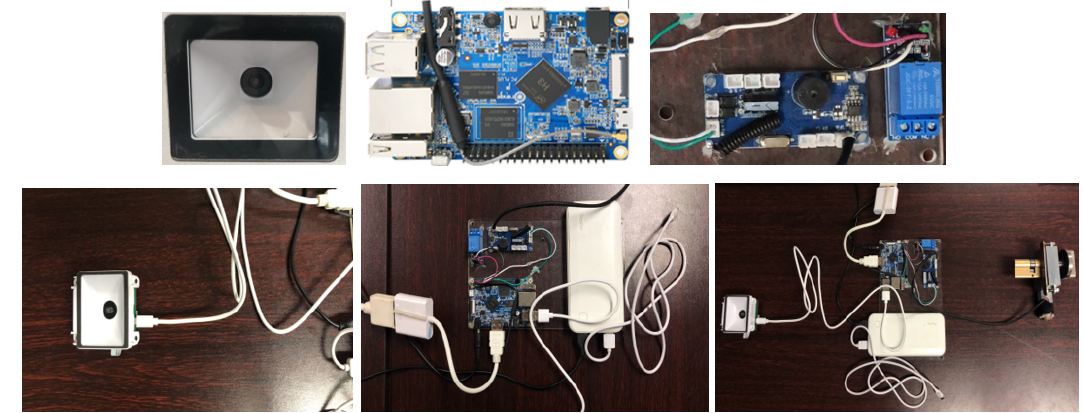
Figure 5. A prototype of OTMP-P2L scheme using the smart lock scenario. ( left ) AD703_G2J1 scanner. ( middle ) Main control units. ( right ) Overall